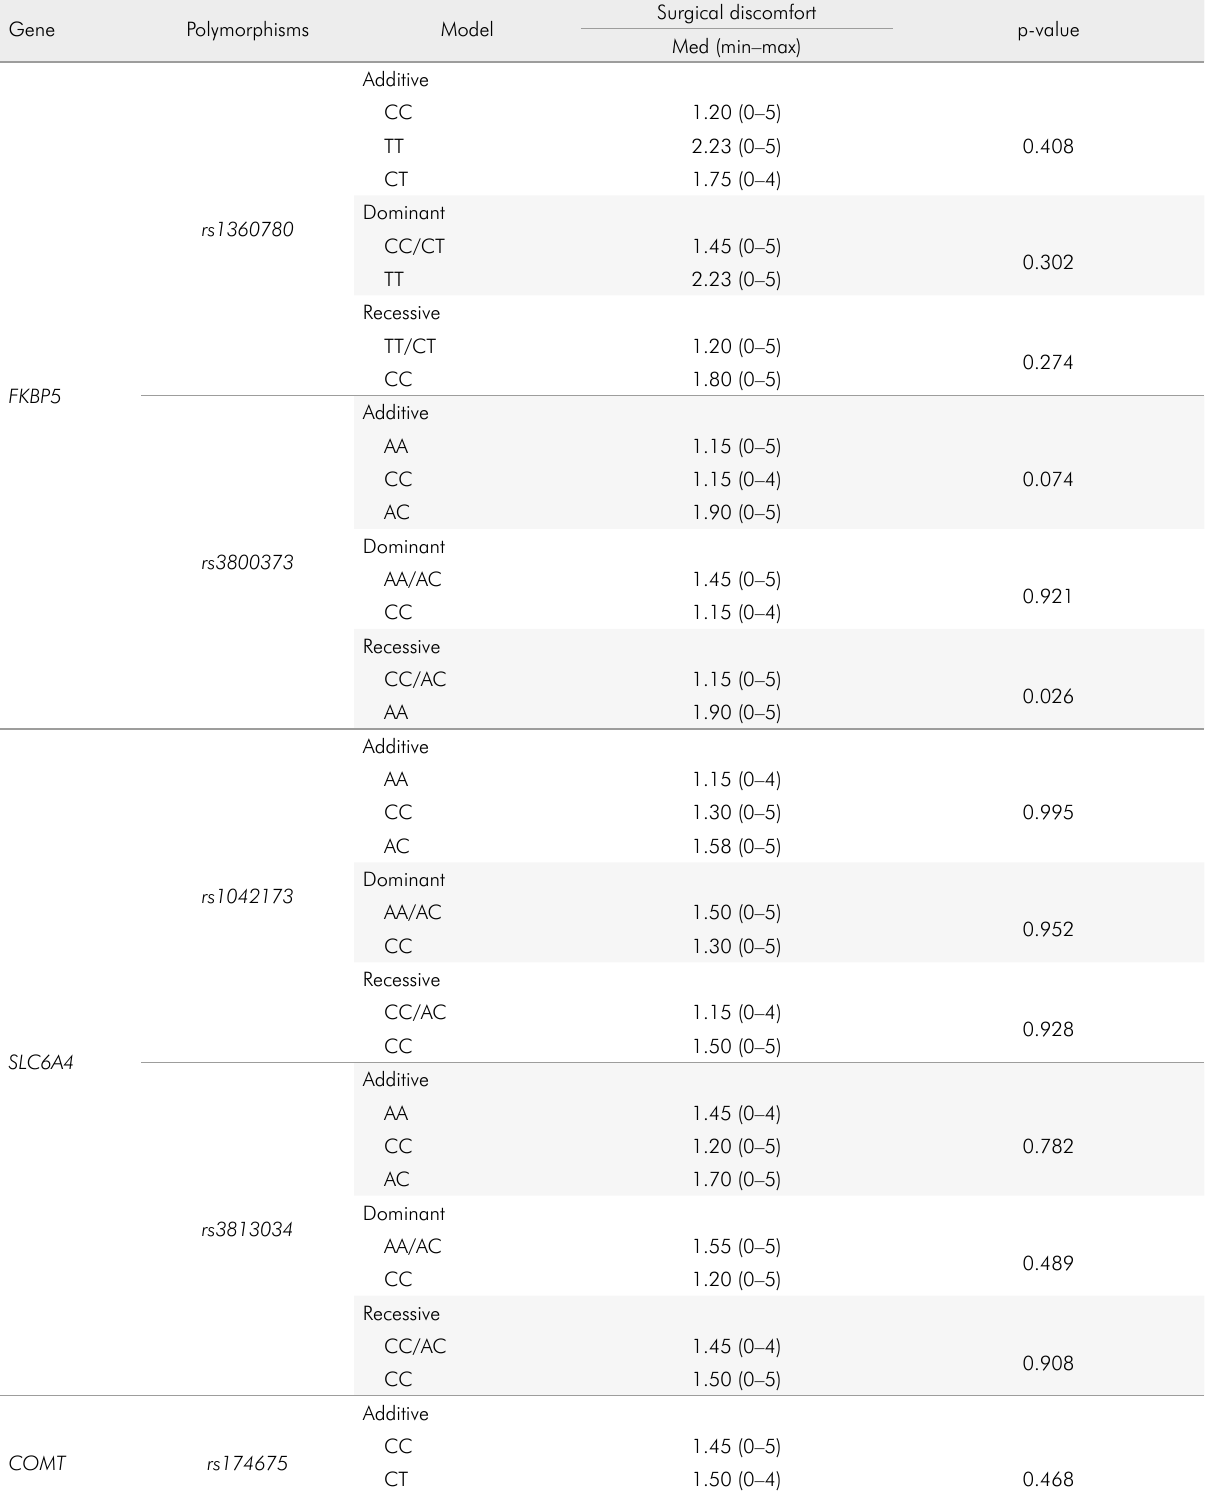
Table 5. Association between surgical discomfort with third molar extraction and genetic